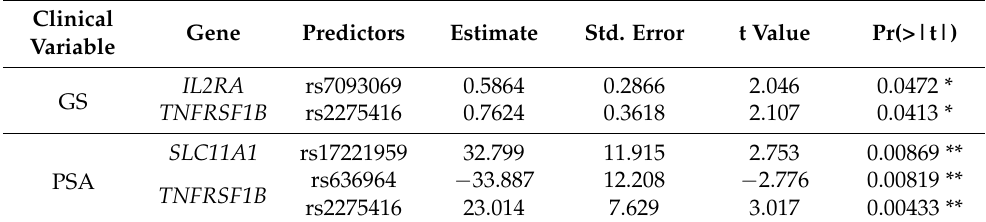
Table 5. The GLMM analysis between the clinical characteristics of patients with PCa and the predictors is shown in Table